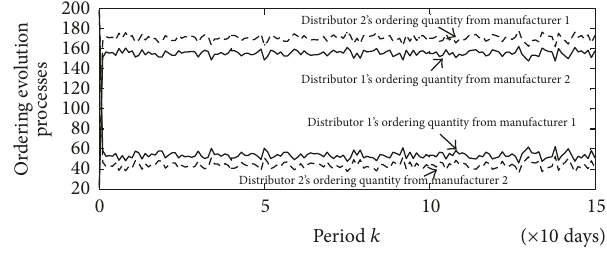
Figure 7: Ordering evolution processes from manufacturer 2 under the common robust strategy ( ×10 4 ton).